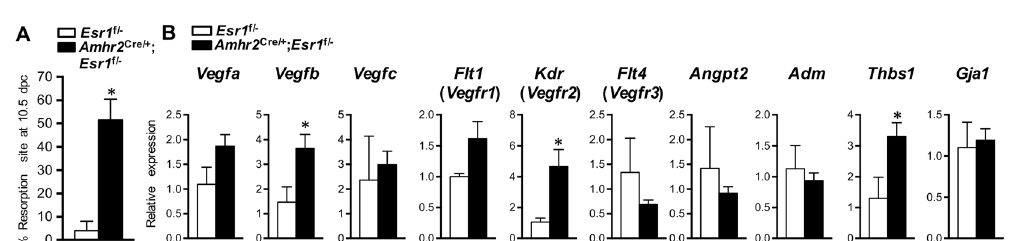
Figure 9. Resorption sites and the transcripts of angiogenesis markers at 10.5 dpc in Esr1 f/ − (N = 3) and Amhr2 Cre/ + ; Esr1 f/ − (N = 8) adult (8–12-week-old) female mice. ( A ) Percentage of resorption sites at 10.5 dpc in Esr1 f/ − vs. Amhr2 Cre/ + ; Esr1 f/ uteri. ( B ) Transcript levels of angiogenic factors ( Vegfa , Vegfb , Vegfc , Flt1 , Kdr , Flt4 , Angpt2 , and Adm ), anti-angiogenic factor ( Thbs1 ), and gap junction protein alpha 1 ( Gja1 ) of implantation sites at 10.5 dpc. * p < 0.05; unpaired t -test. All graphs represent mean ±